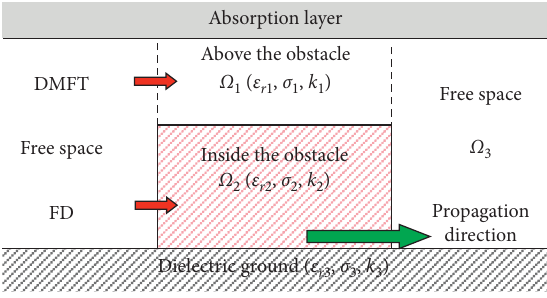
Figure 2: Schematic diagram of domain decomposition.